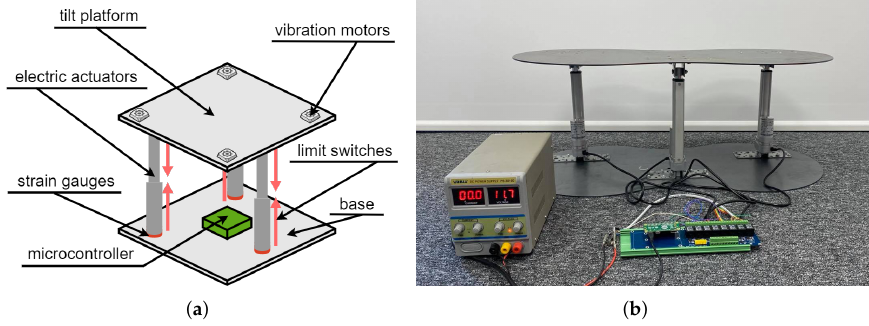
Figure 1. ( a ) A schematic design of the tilt platform. ( b ) The prototype of the tilt